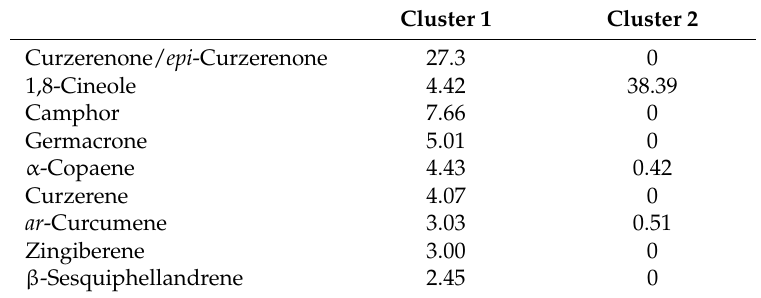
Figure 3. Dendrogram obtained from the agglomerative hierarchical cluster analysis of five Curcuma zedoaria essential oil samples. Table 8. Concentration (%) of centroids used in the cluster analysis of Curcuma aromatica rhizome oils.